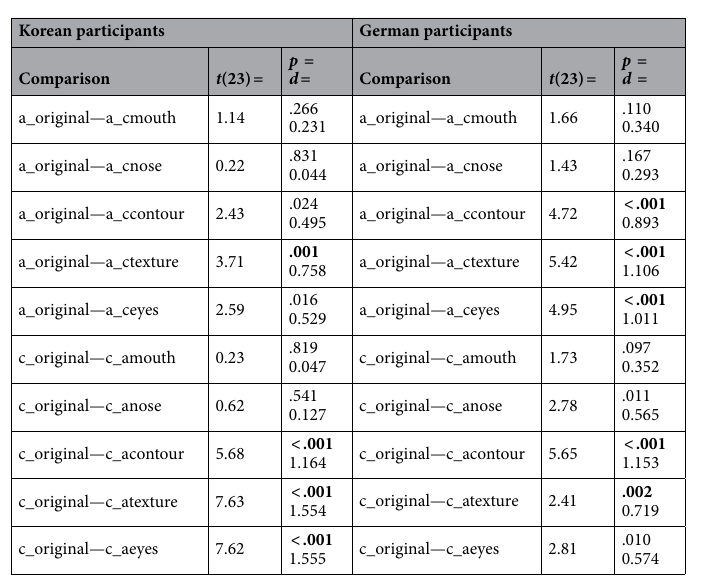
Table 5. Paired t-tests comparing response times for original parent faces to response times for their face variations for Korean and German participants. Significant p-values after Bonferroni correction for multiple significance tests (n = 10) are shown in bold. For more details, see Table